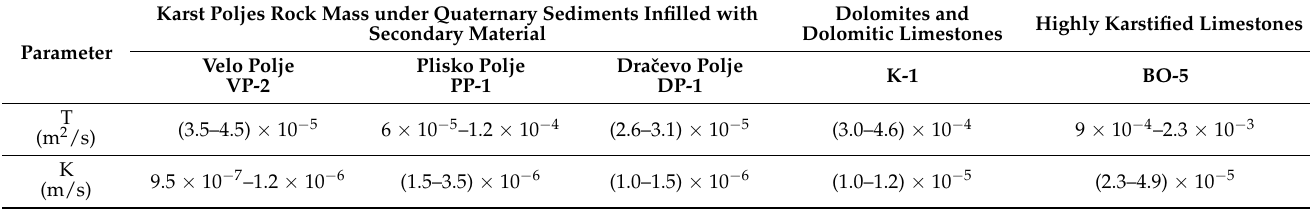
Table 1. Calculated Values of Transmissivity (T) and Hydraulic Conductivity (K) on Vis Island.